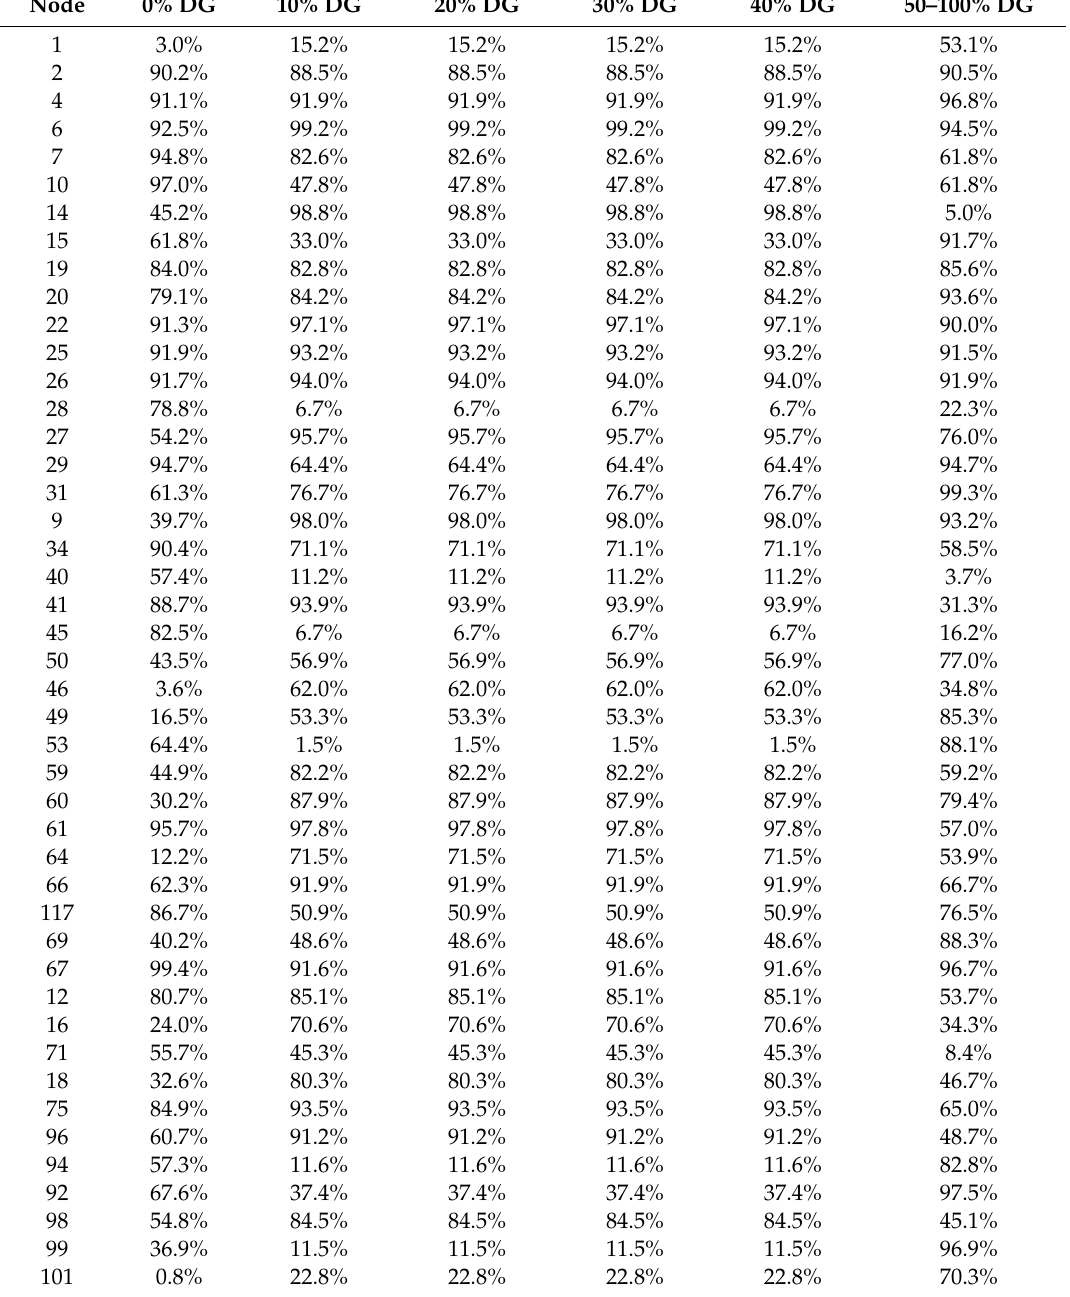
Table 8. Loading per node for case